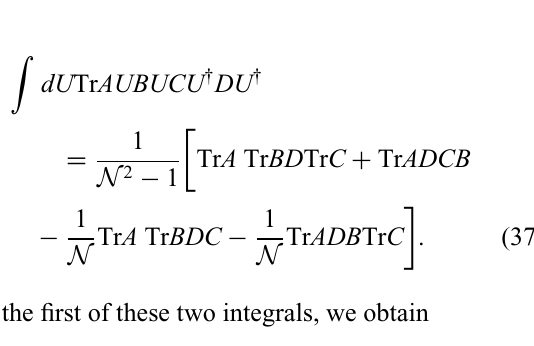
FIG. 12. Various fidelities of random states. Fidelity F = |(cid:6) (cid:2) | (cid:2) (cid:2)| 2 and cross-entropy benchmarking (cid:4) P Q F N |(cid:6) x | (cid:2) (cid:2)| 2 |(cid:6) x | (cid:2) (cid:2)| 2 − 1 for two independent B = P Q x random vectors | (cid:2) P (cid:2) and | (cid:2) Q (cid:2) distributed according to the Porter-Thomas